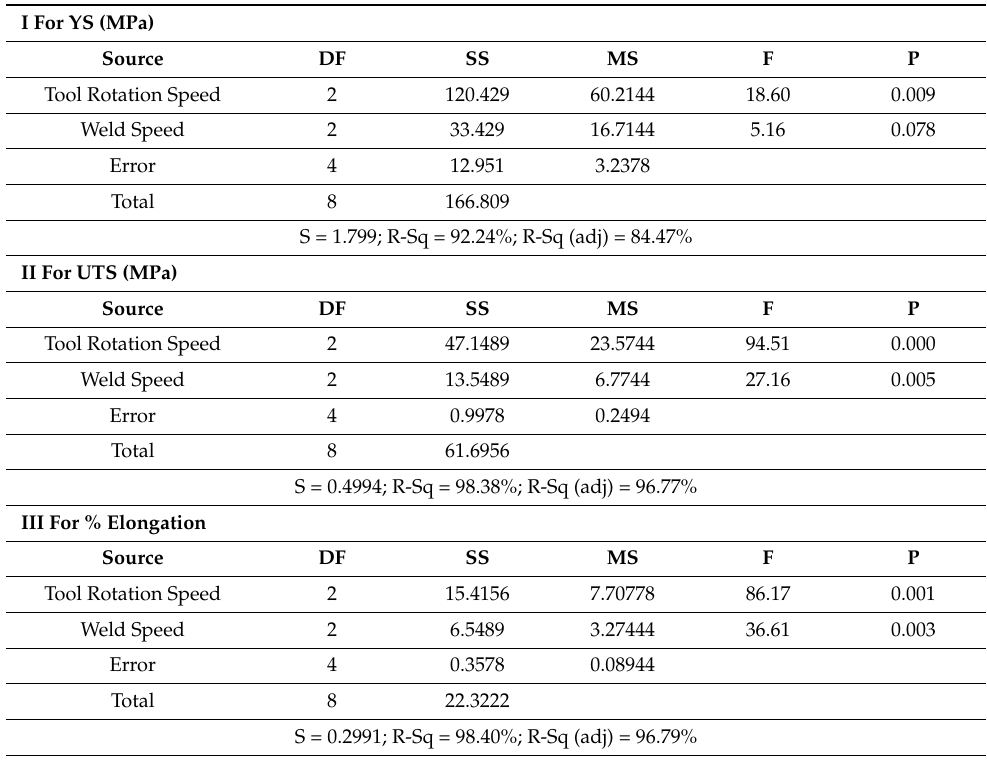
Table 8. Analysis of variance for test results of tensile